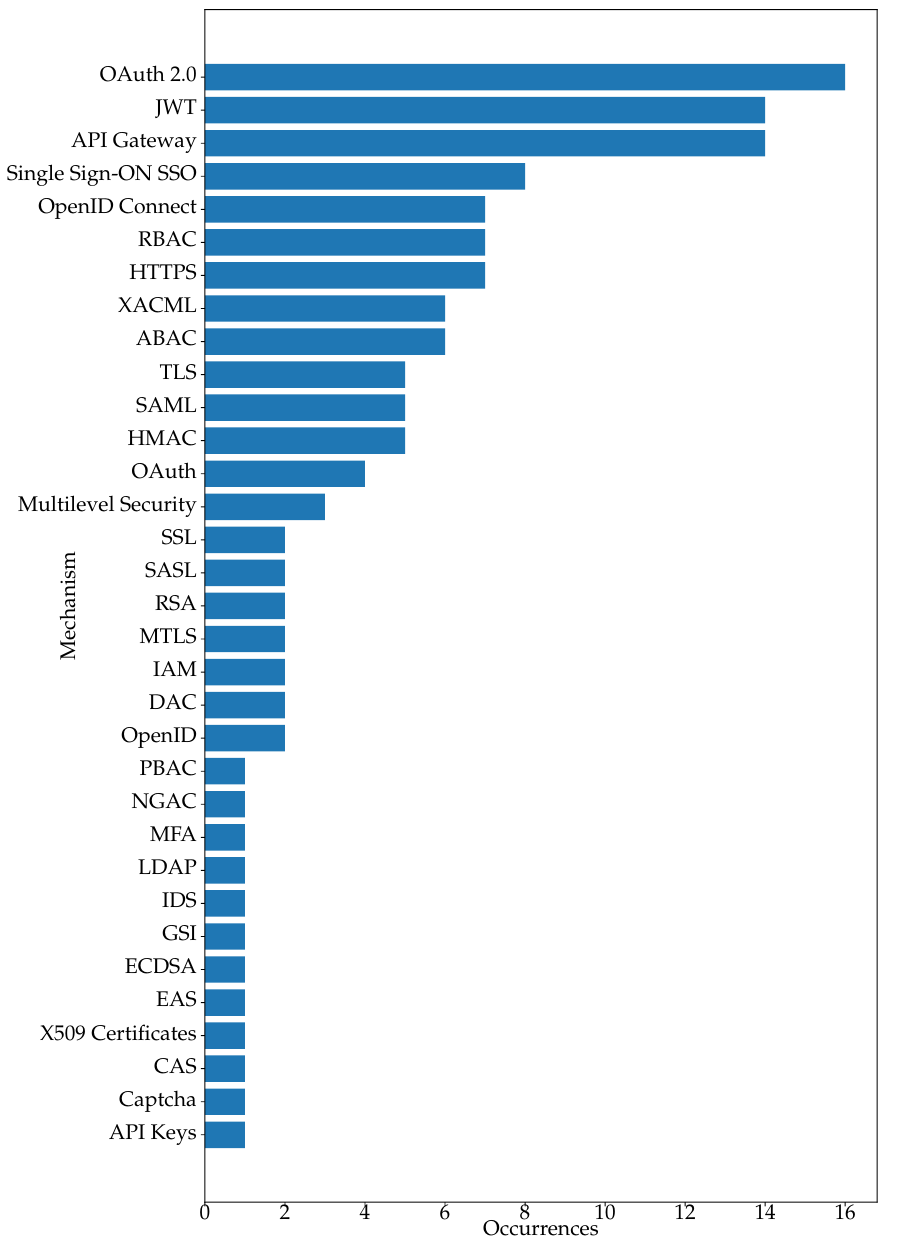
Figure 3. Number of occurrences versus security mechanisms found protocol to protect services that use the REST (Representational State Transfer) [23,25, 362 27], in addition to adopting the HTTPS protocol in data communication